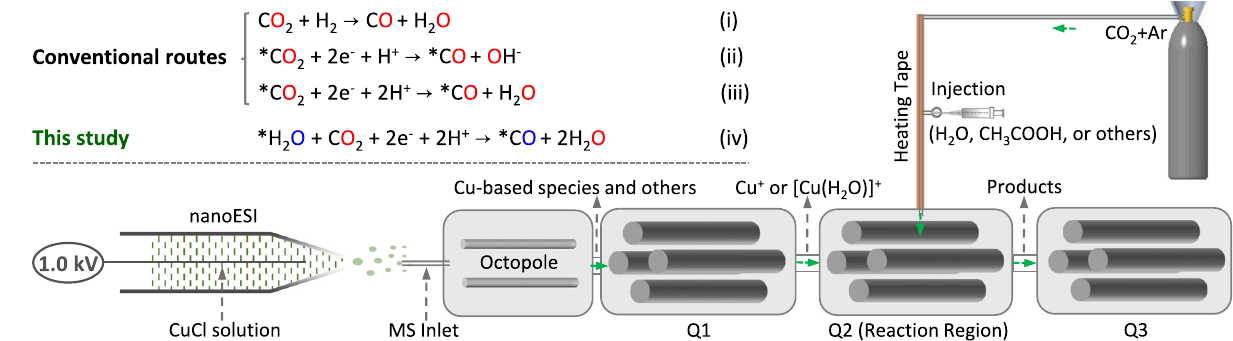
Fig. 1 Schematic diagram of the apparatus for CO 2 reduction and detection of reaction products. (insets in the top left corner are the different routes for generation of CO from CO 2 , in which * means